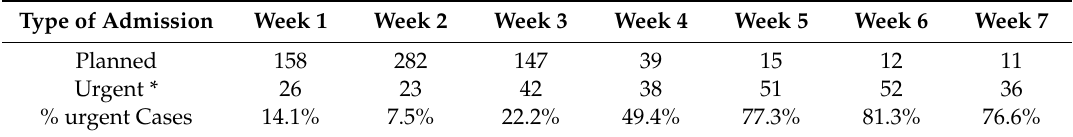
Table 2. Planned vs. urgent acute admissions between Feb 24th and April 12th 2020, by week. Type of